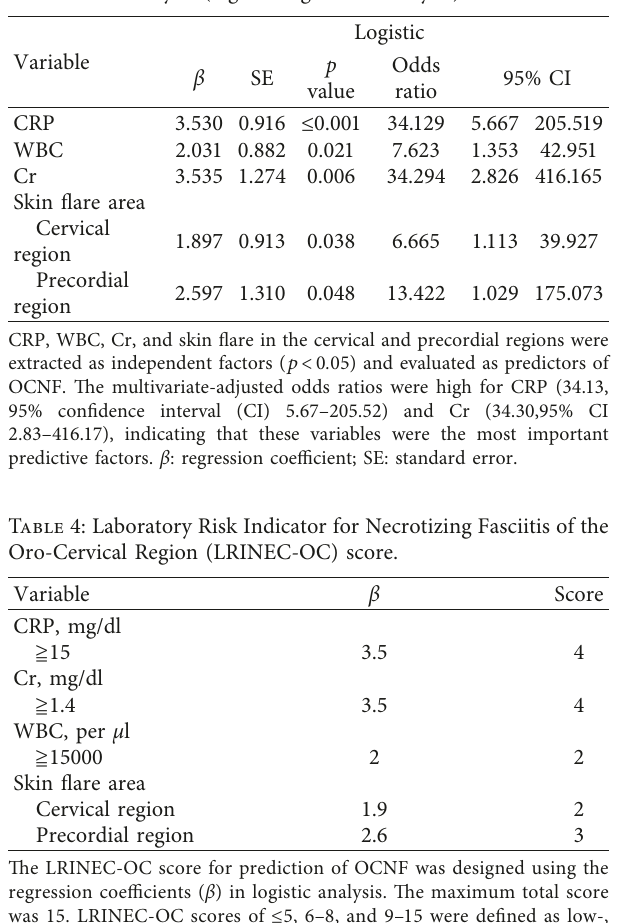
Table 3: Factors with a significant association with OCNF in multivariate analysis (logistic regression analysis).